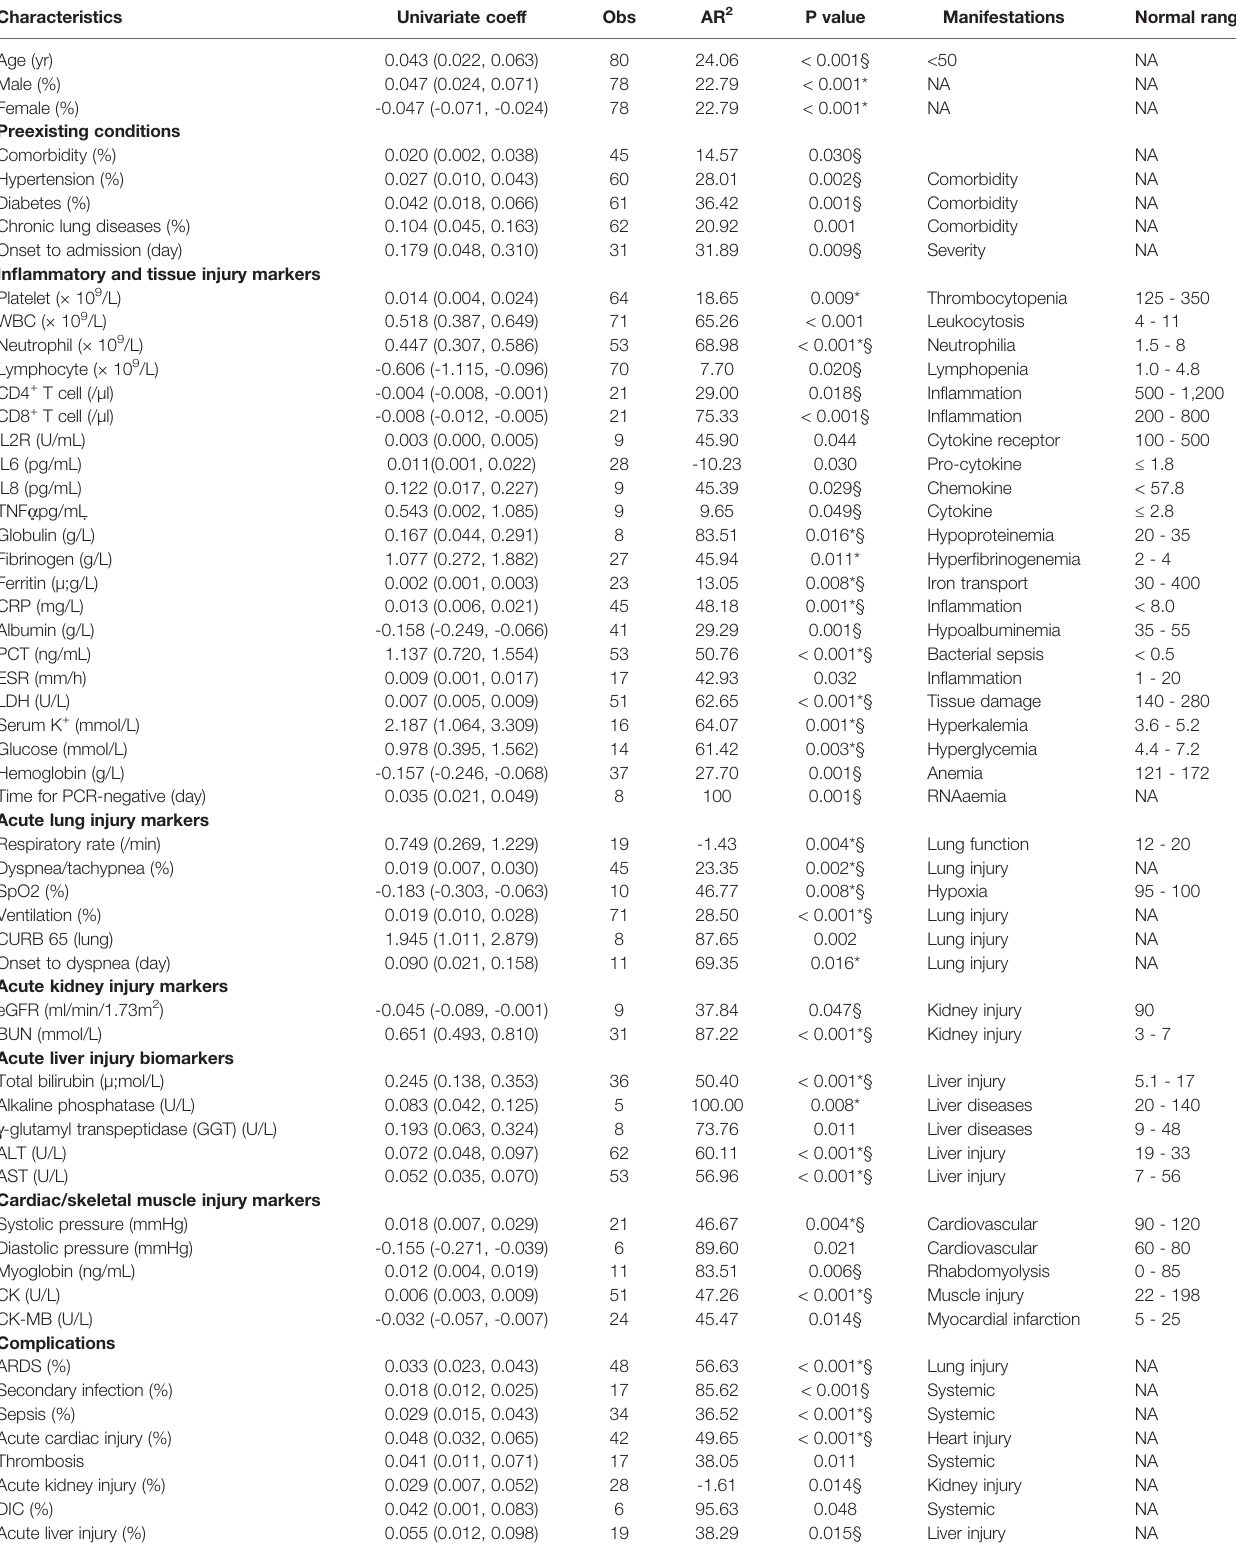
TABLE 2 | D-dimer associated clinical variables (58 of 106 in total with a sample size ≥ 5, P < 0.05) identi fi ed by univariate-regression.